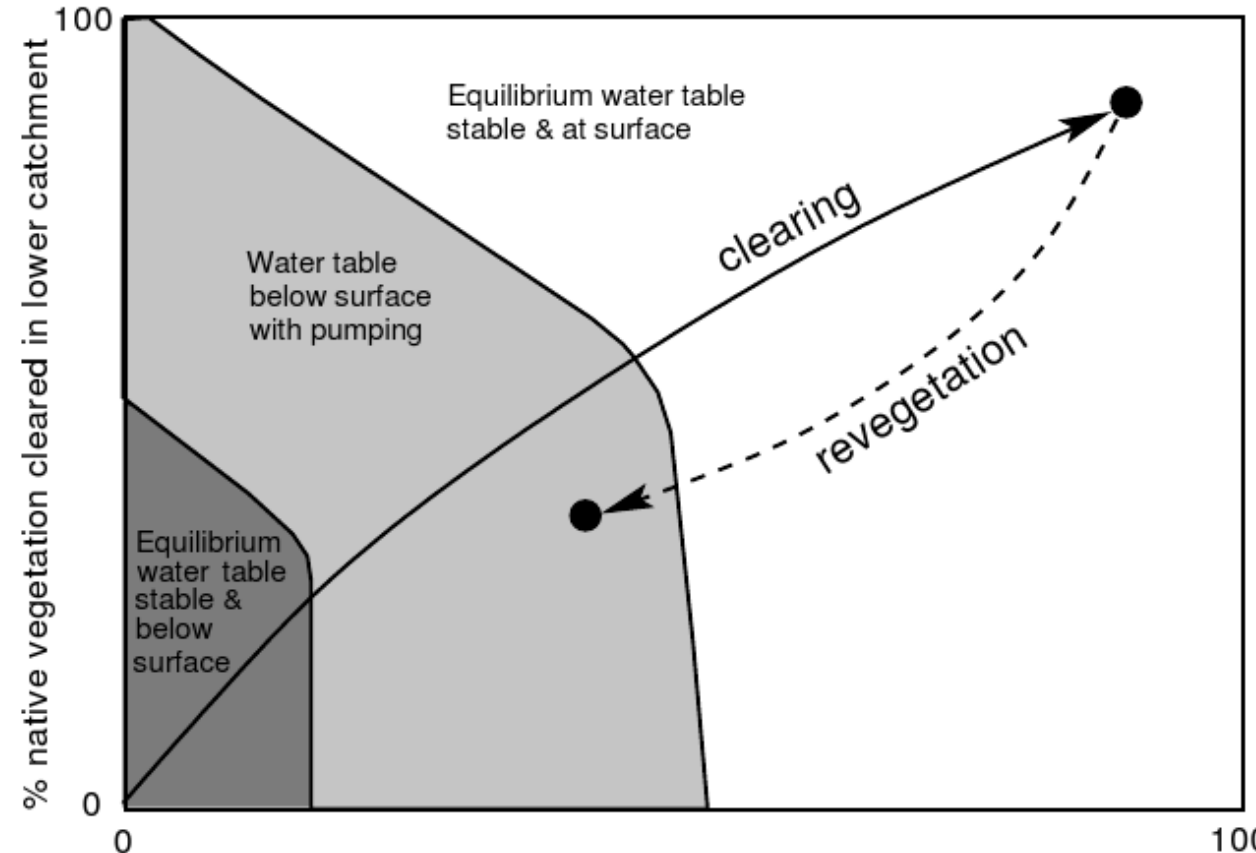
Fig. 7. Equilibrium states of water-table depth for different combinations of vegetation cover, including current levels of groundwater pumping. Avoiding water tables reaching the surface equilibrium condition will require a trajectory of revegetation something like that depicted, in combination with continued pumping. A reduction in average rainfall (over a prolonged period) would alter this picture. (After Anderies et al. 2006). Erratum (added 31 March